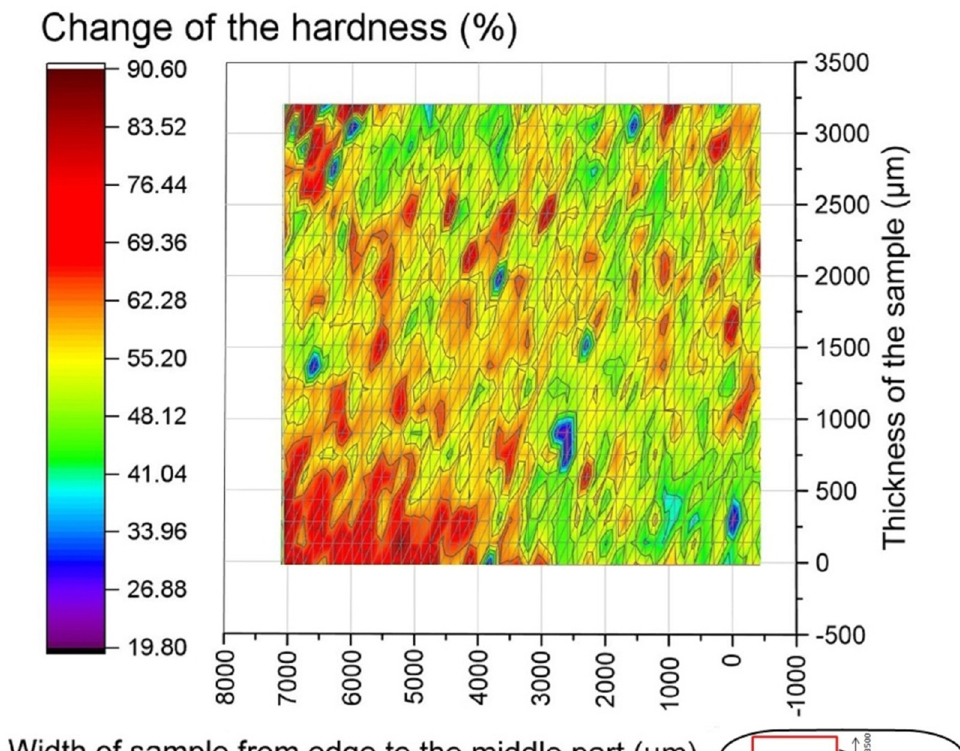
Figure 6. Change of the nano-hardness of sample ε 10 (in %).